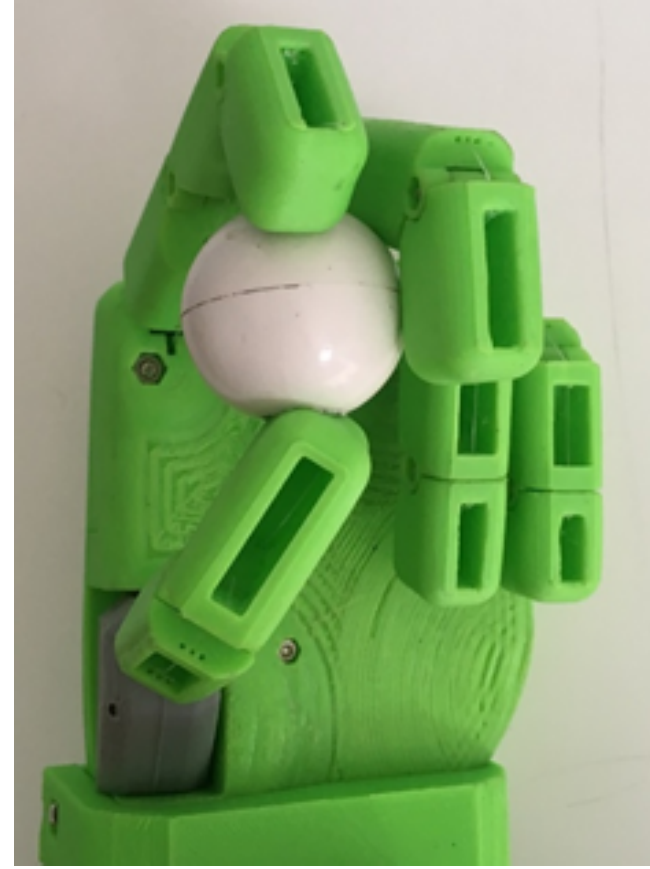
Figure 10. Prosthesis holding a sphere through a tridigital hold.